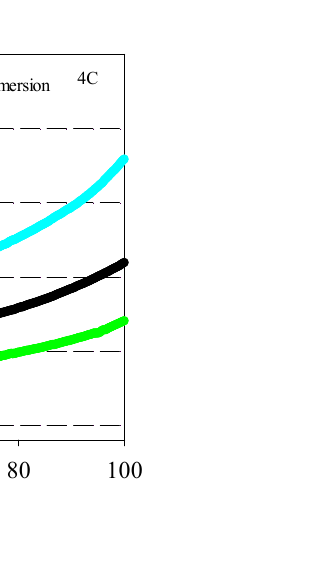
Figure 4. The effect of fluid type and immersion ratio on average battery surface temperature for various discharge rates of ( a ) 1C, ( b ) 2C, ( c ) 3C and ( d ) 4C (T inlet = 25 °C).